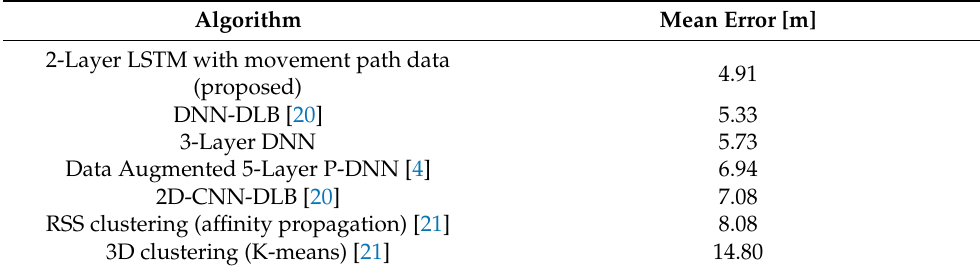
Table 4. Mean error of positioning algorithms on the TUT